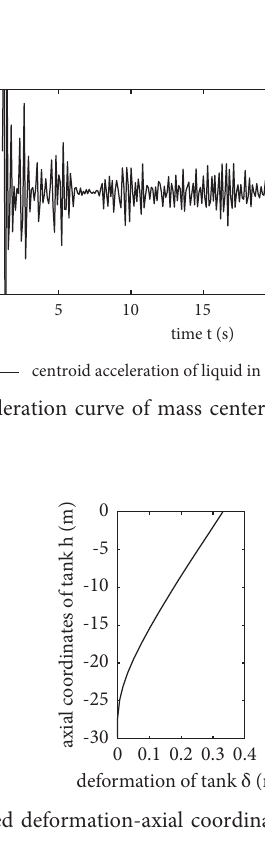
Figure 14: Acceleration curve of mass center of the liquid in tank III.